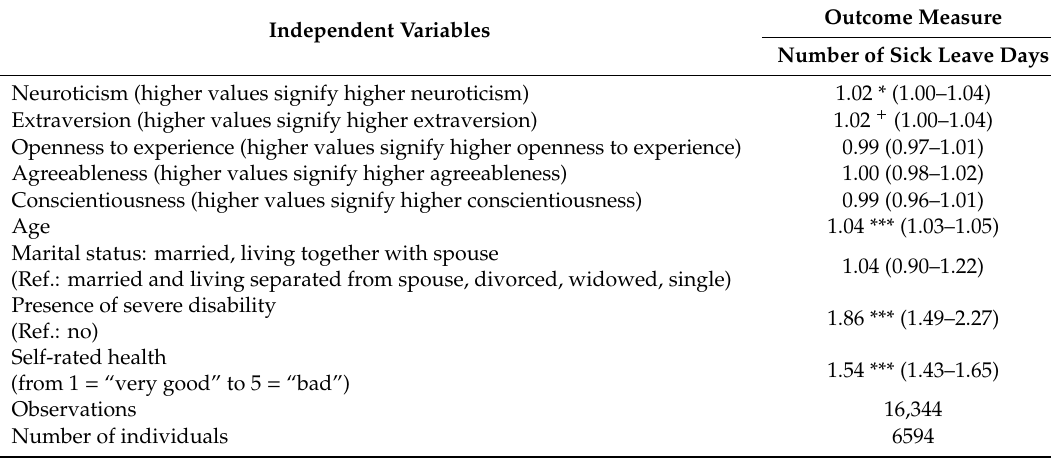
Table 2. Results of Poisson FE regression models with number of sick leave days in the preceding year as outcome measure; year 2005, 2009, and 2013. Outcome Measure Independent Variables Number of Sick Leave Days Neuroticism (higher values signify higher neuroticism) 1.02 *